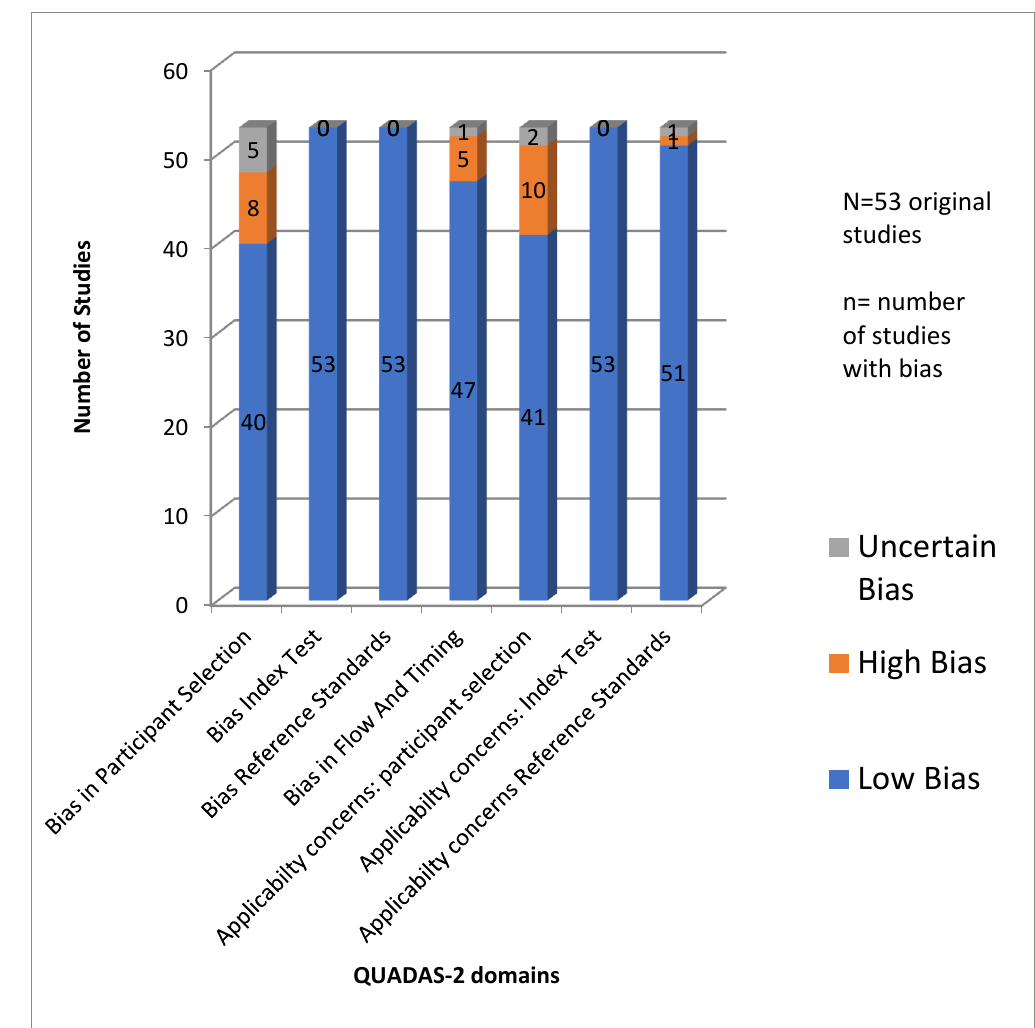
Figure 1. Analysis of publication bias metrics for literature on cognitive impact of air pollution using QUADAS-2.